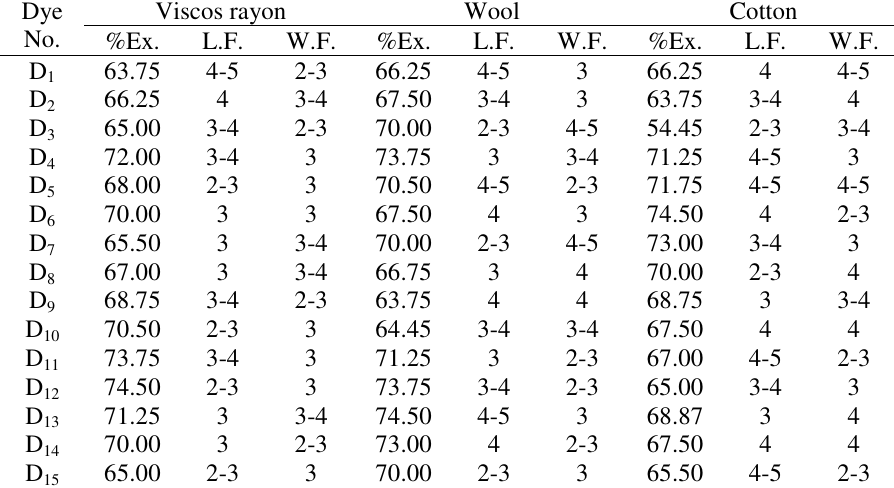
Table 2. % Exhaustion, Light fastness and Wash fastness